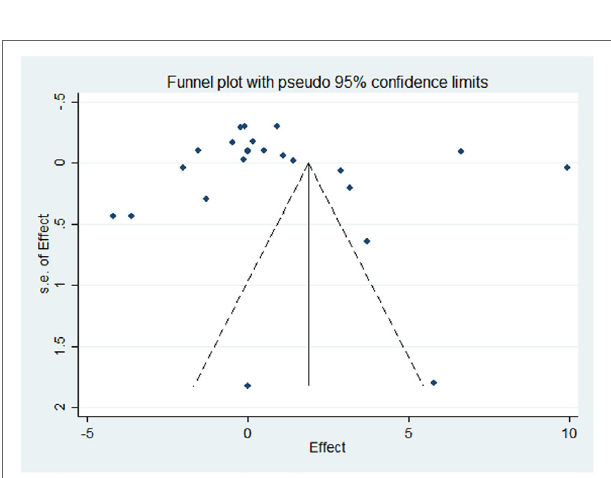
FigURe 4 | Funnel plot evaluating publication bias on the effect of OC concentration on atherosclerosis or calcification. The SE of the mean difference in osteocalcin concentration for each study is plotted against its effect size (horizontal axis). Although the distribution of the studies within the funnel plot does not appear symmetrical, there was no statistical evidence of publication bias (Egger’s statistic p = 0.279).